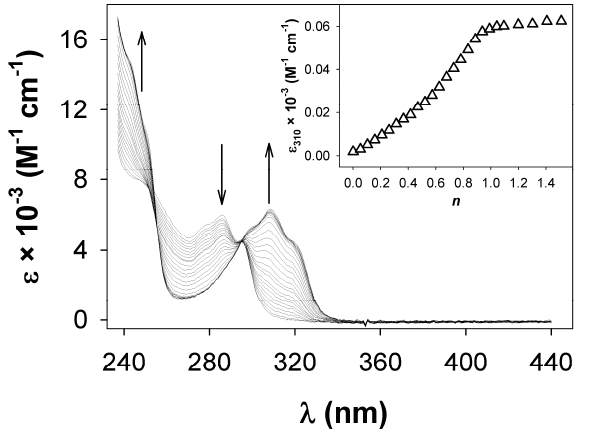
Figure 2. Absorption spectra recorded during the titration of a MeCN solution of 2a (10 − 5 M) with zinc(II) ion. In the inset, the titration profile shows the formation of a 1:1 adduct ( n = equiv. of Zn II ion/equiv. of 2a ).